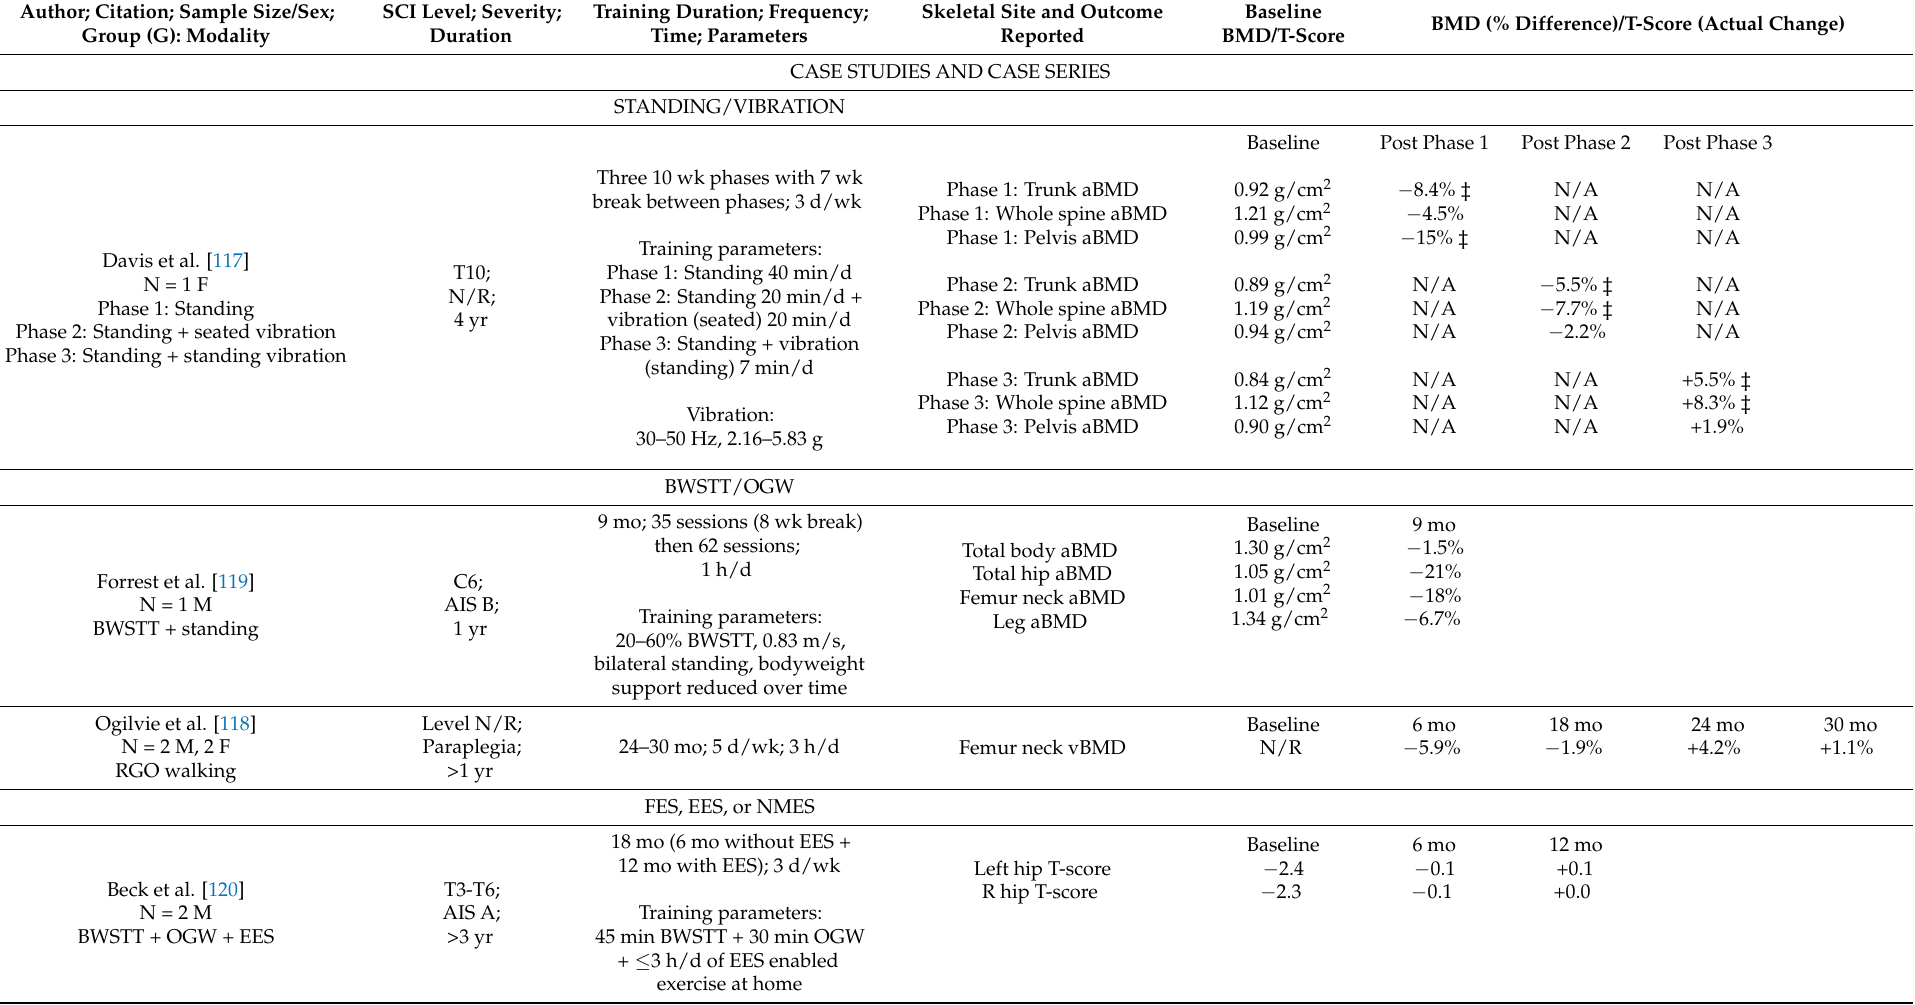
Table 3. Case studies, case series, and cross-sectional studies evaluating the effects of activity-based physical therapy (ABPT) and/or loading on bone mineral density (BMD) or T-scores in adults with chronic spinal cord injury